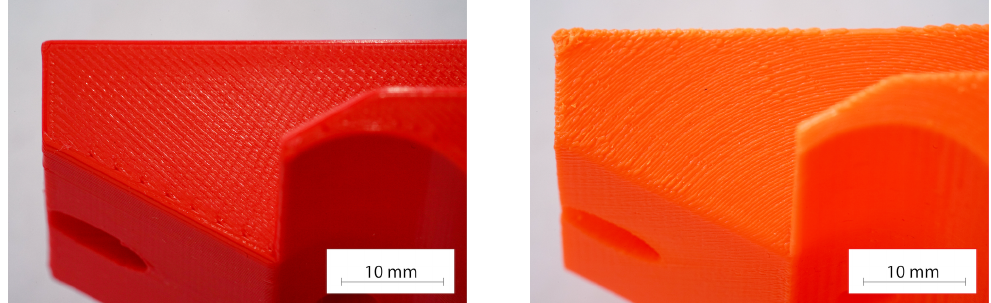
Figure 21. Horizontal, upward 90° surface printed on a Prusa Mk3s ( red ) and the RotBot ( orange